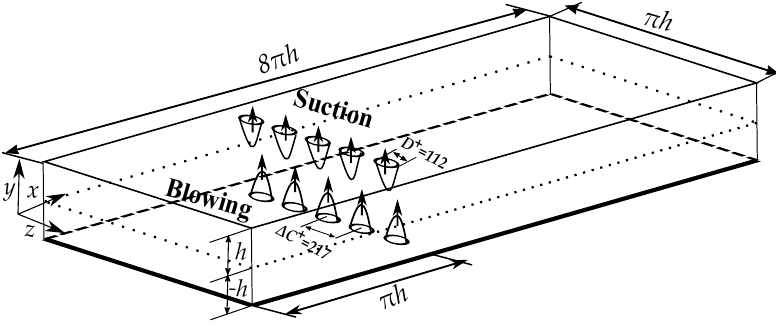
Figure 1. Schematic of the channel with spanwise local